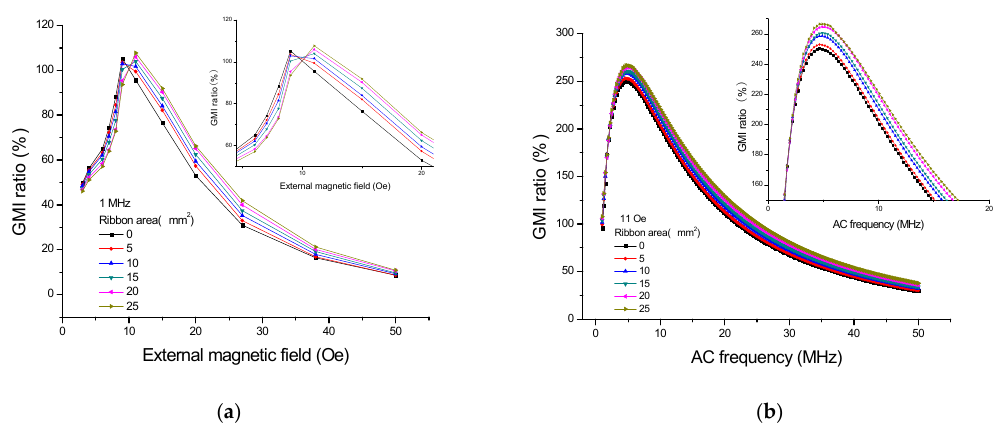
Figure 4. The giant magnetoimpedance responses when the ribbons are tested on the top of the giant magnetoimpedance sensor I: ( a ) field dependence and ( b ) frequency dependence.